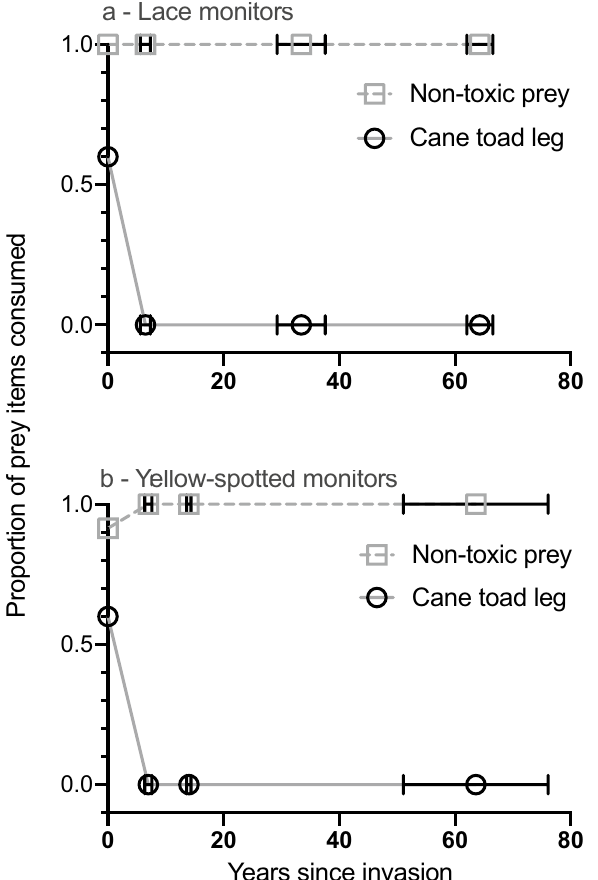
Figure 2. The proportion of cane toad ( Rhinella marina ) legs and non-toxic baits consumed by (a) lace monitors ( Varanus varius ) and (b) yellow-spotted monitors ( Varanus panoptes ) as a function of the number of years since toads first invaded an area. Lace monitors were offered a chicken neck or toad leg, while yellow-spotted monitors were offered a chicken egg, sardine or toad leg. Error bars represent standard errors surrounding years since cane toads